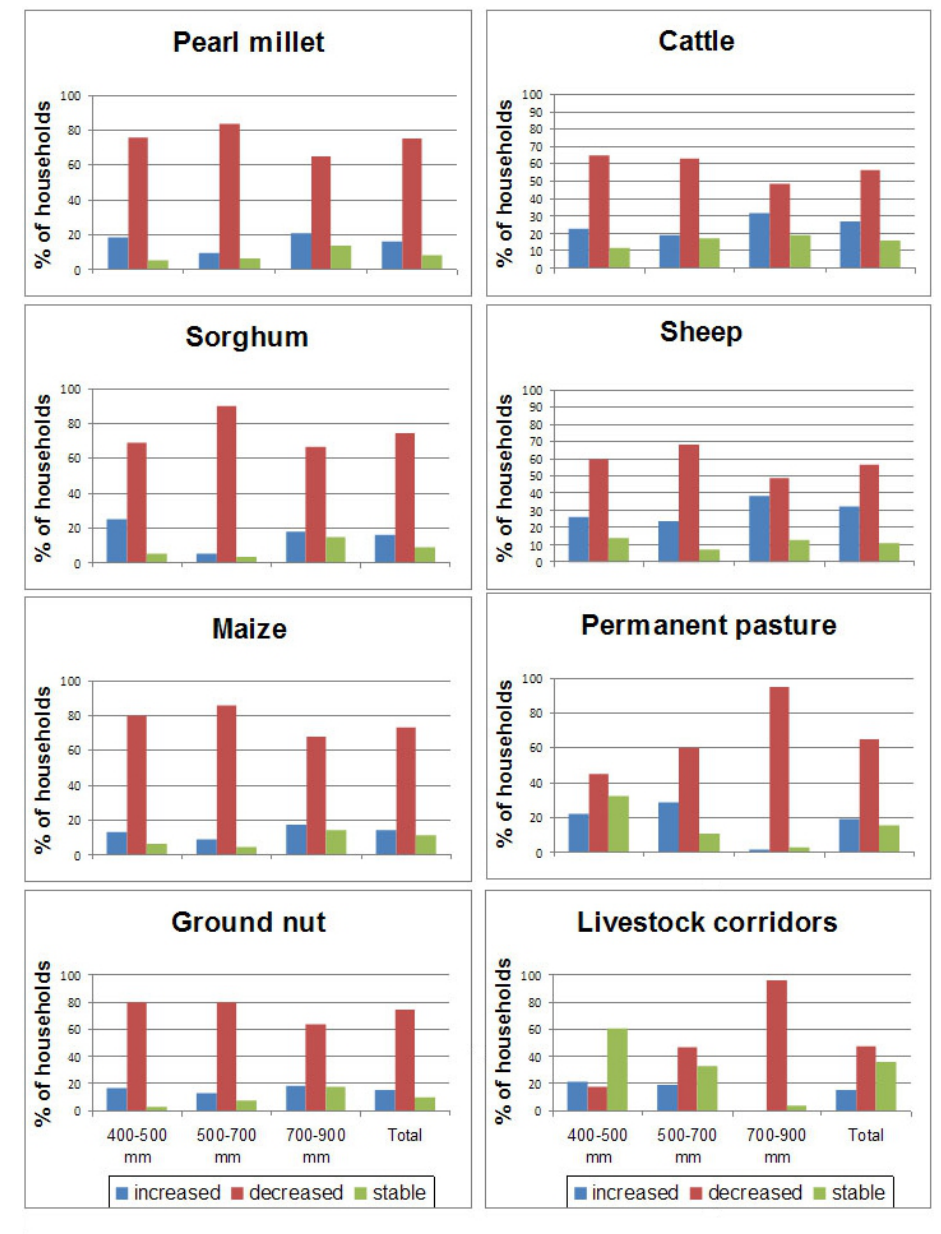
Fig. 3. Percent of households in three rainfall zones stating a change or no change during the past 20 years in crop production (pearl millet, N=1056, p < 0.05; sorghum, N=770, p < 0.05; maize, N=468, p < 0.05; and groundnuts, N=553, p < 0.05), livestock production (cattle, N=575, p < 0.05 and sheep, N=601, p < 0.05) and change in availability of permanent pasture (N=860, p < 0.05), and livestock corridors (N=852, p < 0.05). Significance levels refer to differences in perceptions between rainfall